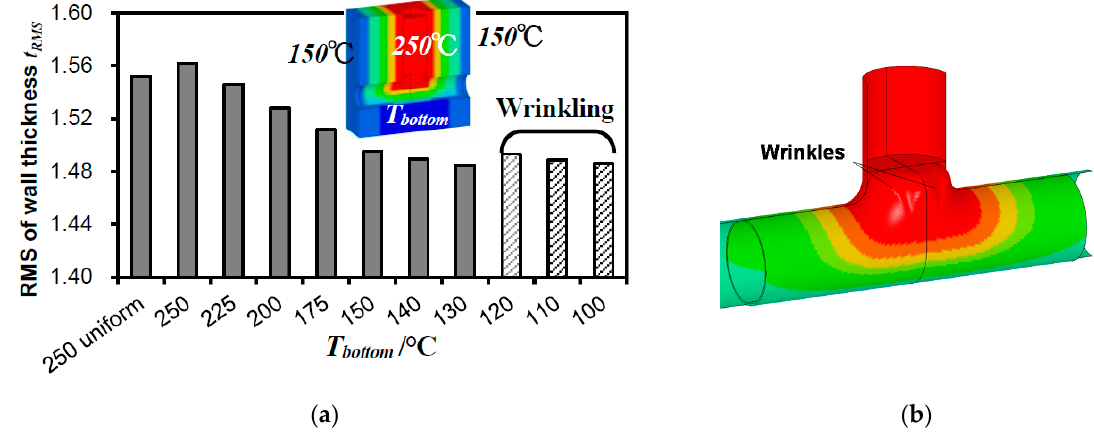
Figure 16. Effect of T bottom on RMS of wall thickness distribution along the bottom part. ( a ) The t RMS ; ( b ) wrinkles occurred at bulging head.